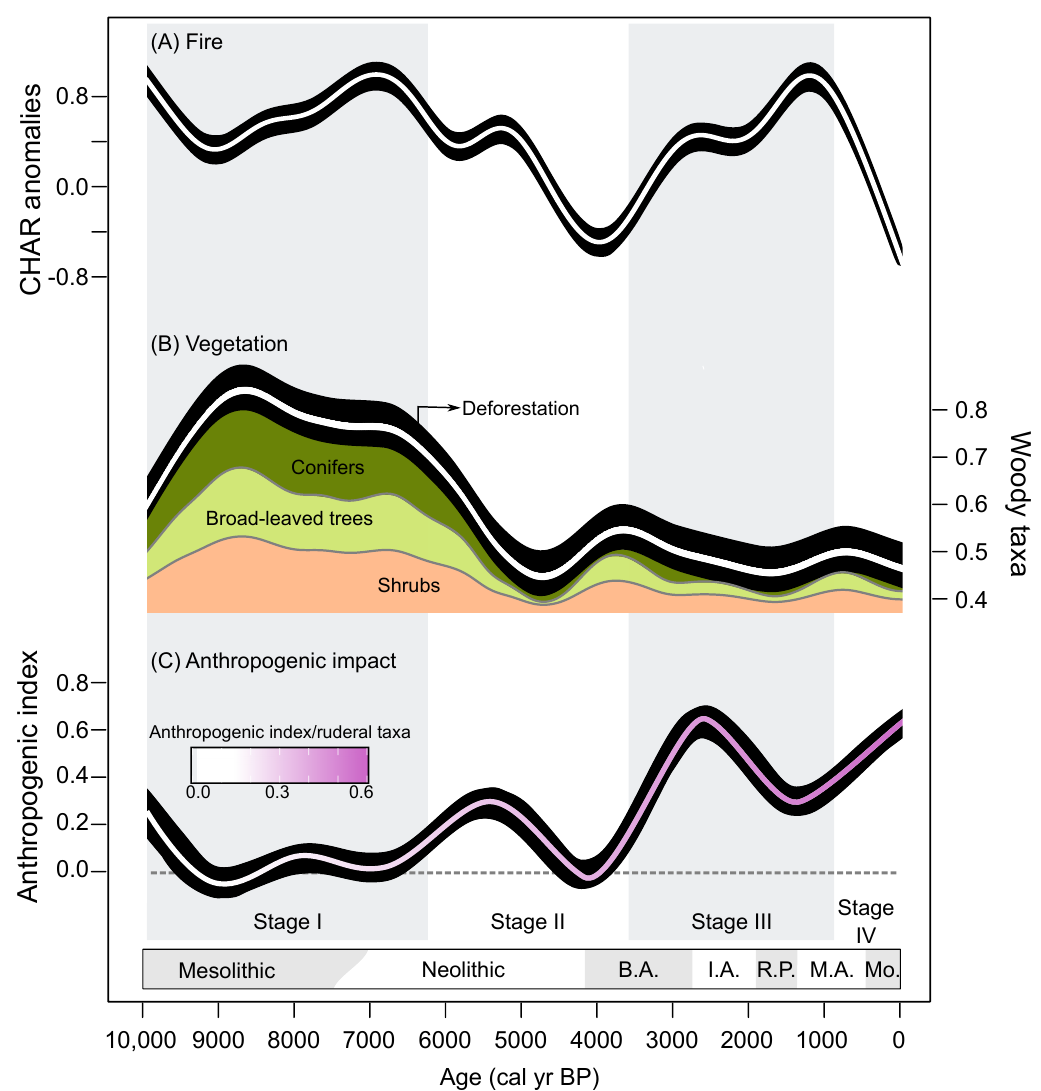
Figure 5. Holocene trends in fire, vegetation and anthropogenic impact in the Northern Mediterranean. ( A ) Regional biomass burning as estimated by a GAM applied to the charcoal data from the sub-region ( B ) Vegetation openness inferred from woody-to-herbaceous pollen taxa. The relative proportion of conifers, broad-leaved trees and shrubs is shown. ( C ) Anthropogenic index as a function of time. The pink shading represents the total anthropogenic index-to-ruderal taxa ratio. The arrow shows the onset of pronounced deforestation depicted in Figure 7. In all cases, the black shading depicts 95% confidence intervals for the estimated